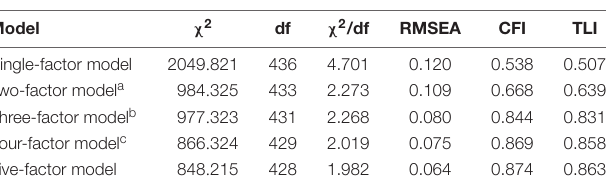
TABLE 4 | Structural